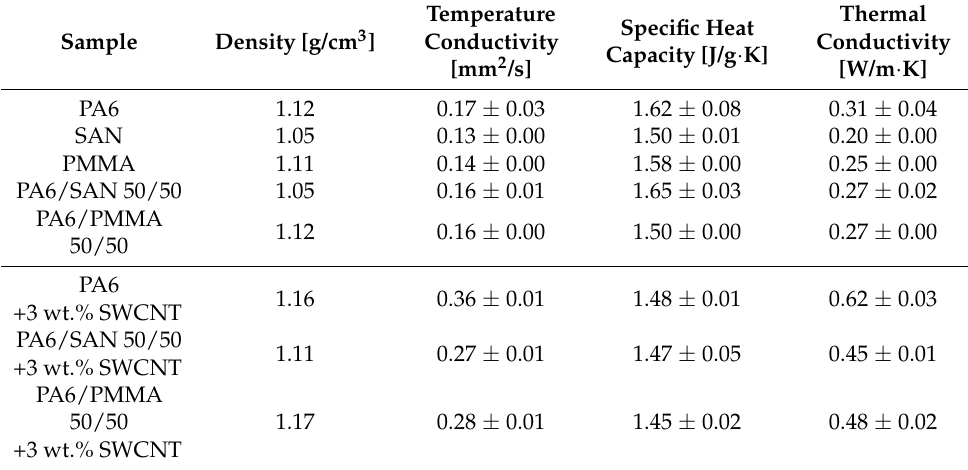
Table 6. Results of thermal conductivity measurements of different